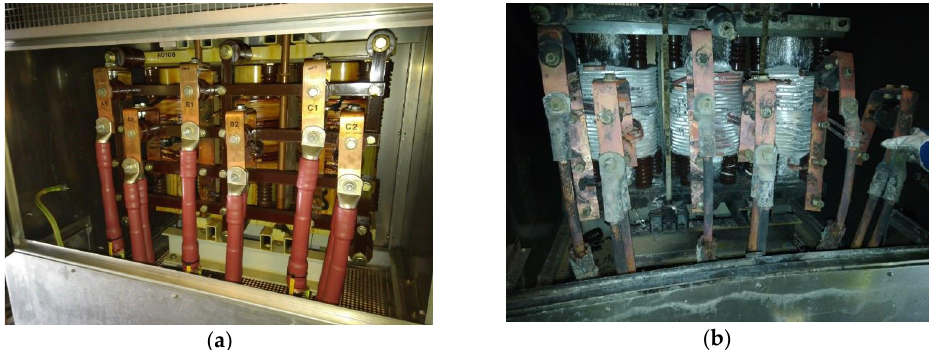
Figure 2. Relay with traces of white adipic acid crystals [16].